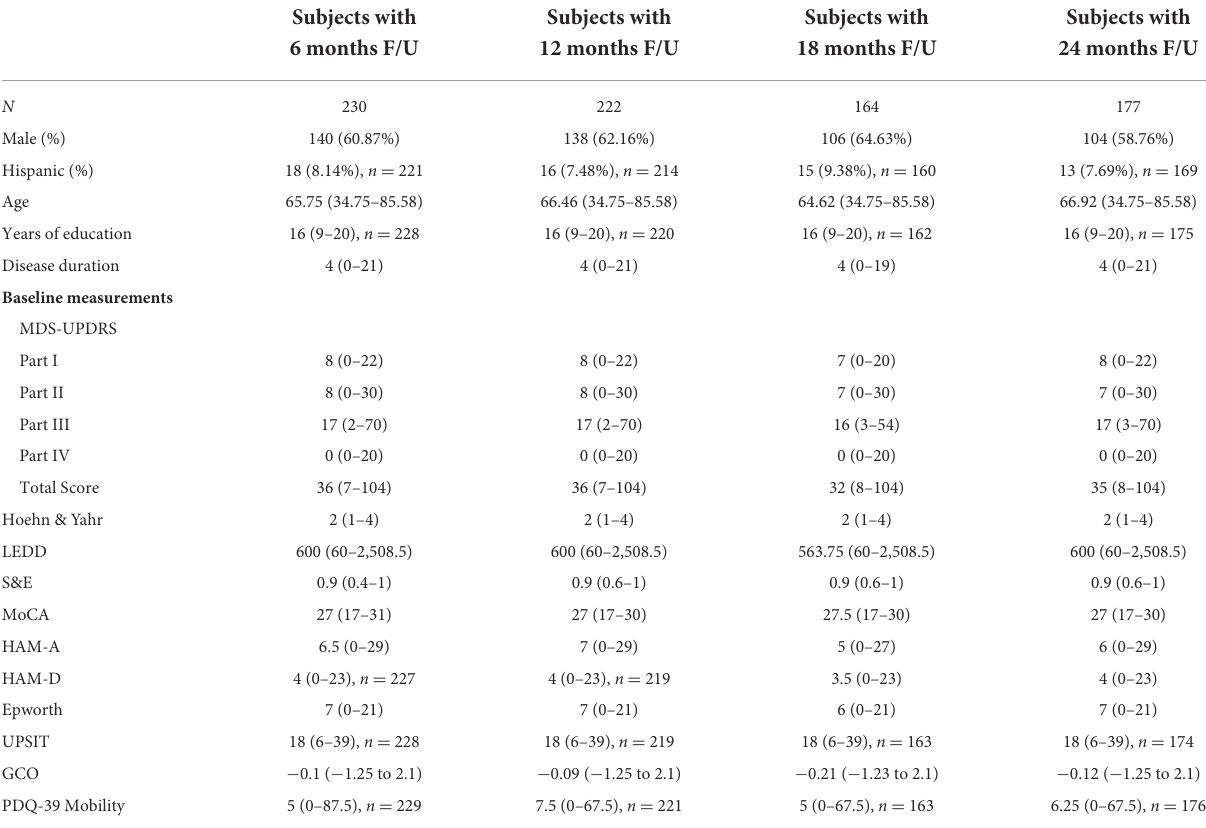
TABLE 1 Demographic and baseline clinical measurements in subjects with the designated length of follow-up. Subjects with Subjects with